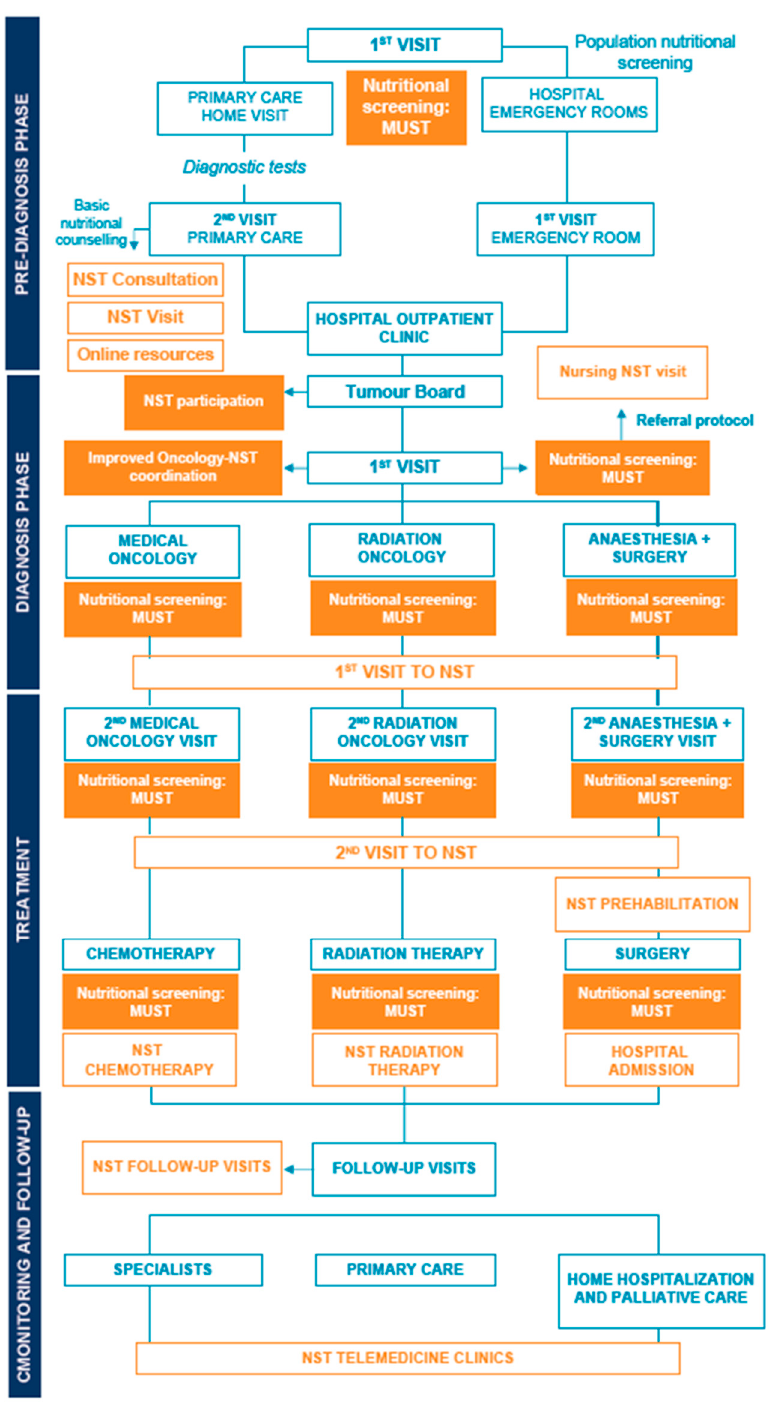
Figure 1. Prototype of the integrated care plan, including oncology and nutrition plans, during pre- diagnosis, diagnosis, treatment, monitoring, and follow-up phases. A summary map was produced by identifying the status of nutritional intervention in cancer patients and healthcare plans of eight sites of the autonomous community of Andalusia using a design thinking technique. This was the basis upon which the areas with potential for improvement were defined. Solutions were devised and prioritized according to impact and feasibility. Considering the ideas for improvement, a prototype of an integrated care plan (oncology and nutrition) was designed with aspects considered to be minimum essential requirements that could potentially be rolled out across all healthcare sites. Orange depicts the interventions that are part of the nutrition plan. Priority improvement ideas are shaded. MUST: Malnutrition Universal Screening Tool; NST: Nutritional Support